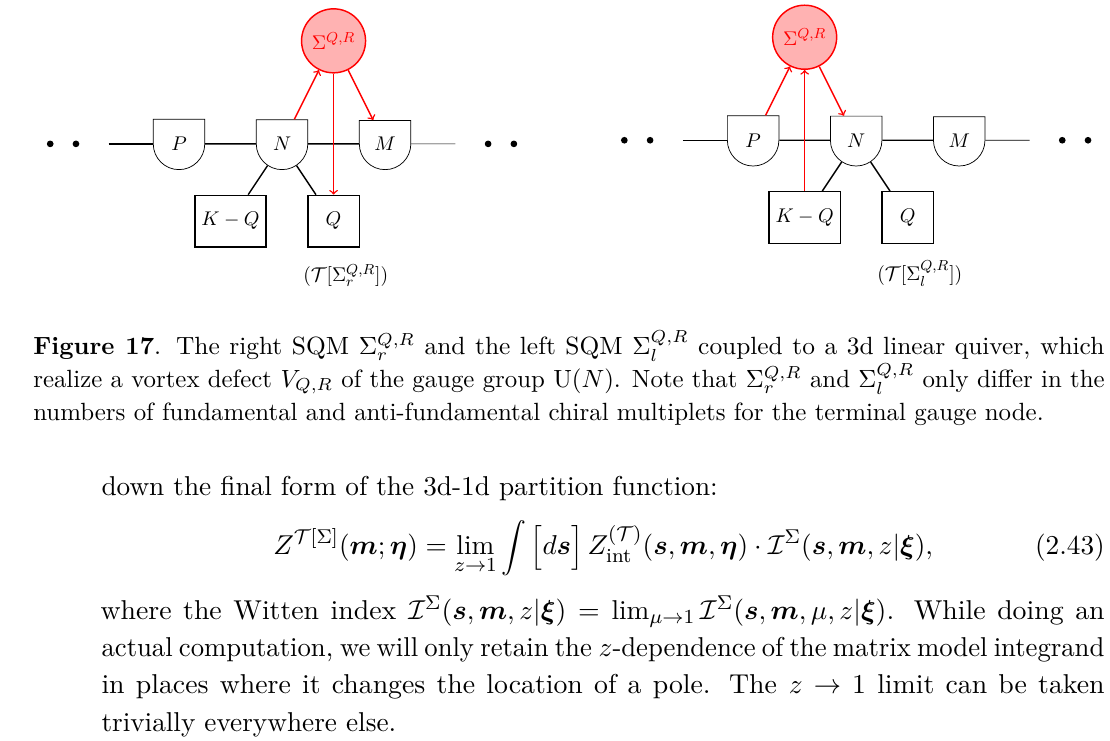
and the left SQM Σ Q,R coupled to a 3d linear quiver, which r l of the gauge group U( N ) . Note that Σ Q,R and Σ Q,R only differ in the Q,R r l